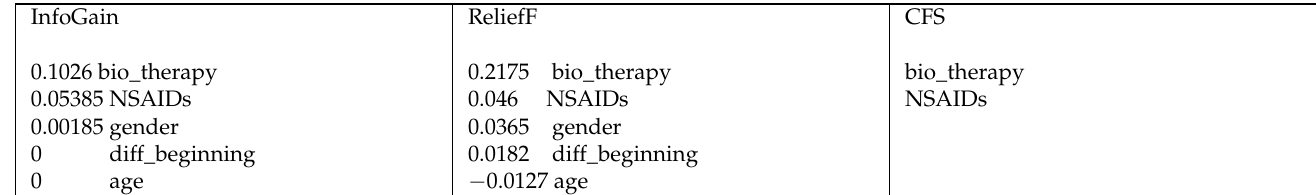
Table 20. The results of the attribute selection